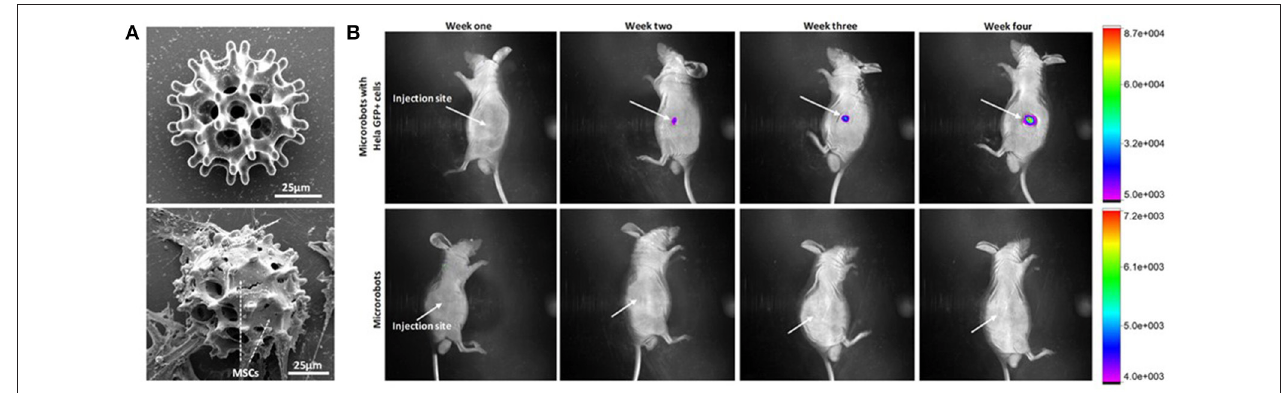
FIGURE 3 | Use of microrobots for cell transport and proliferation of cells. (A) SEM images of magnetically actuated nanorobot before and after cell seeding. (B) In vivo fluorescence imaging of HeLa GFP with cells loaded nanorobots illustrating the migration of cells after injection into the right dorsum of the nude mice (Li